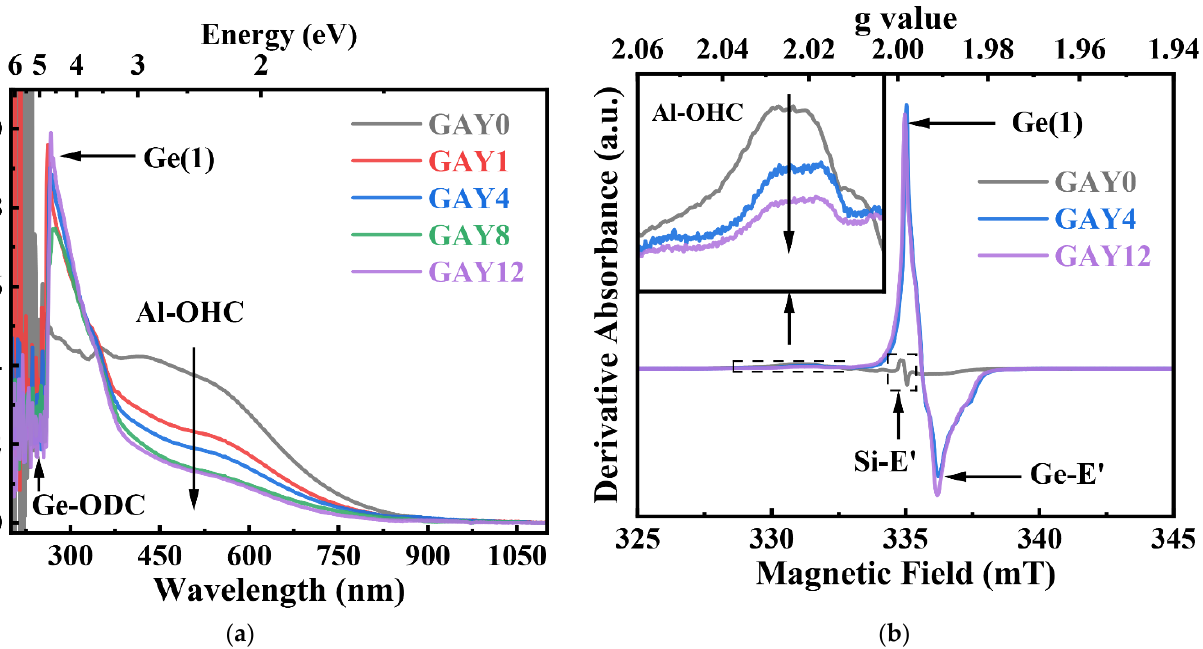
Figure 8. ( a ) RIA and ( b ) CW-EPR spectra of irradiated GAY samples.